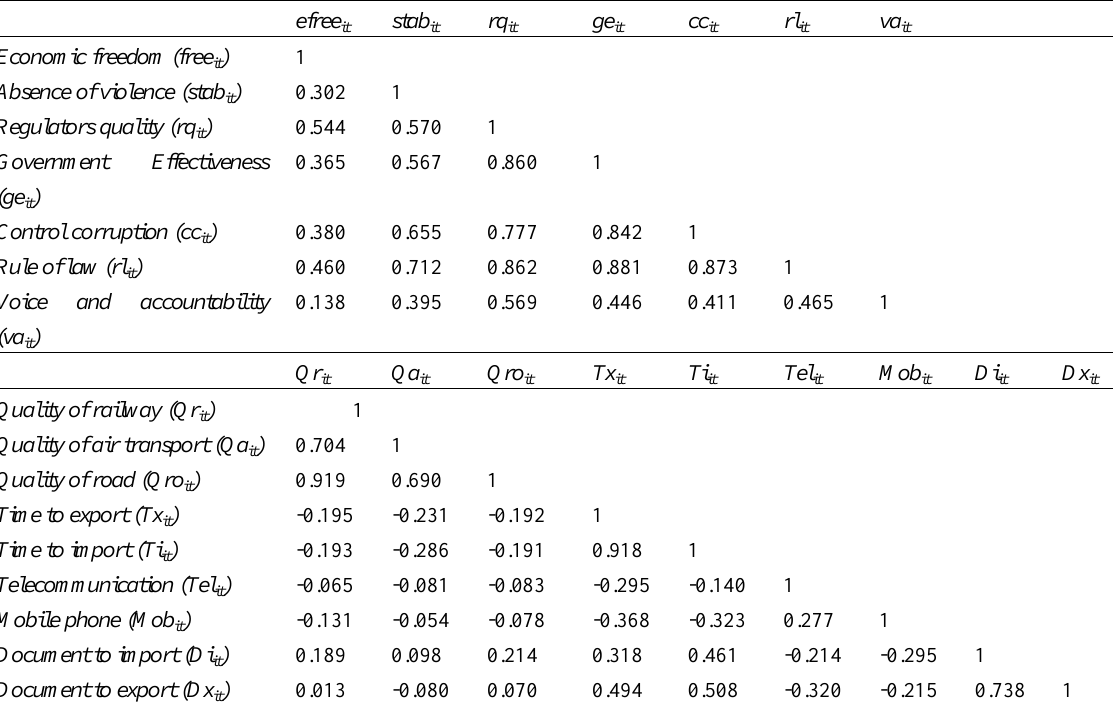
Table 9 : correlations institutional quality, transport and border efficiency, physical and communication infrastructure